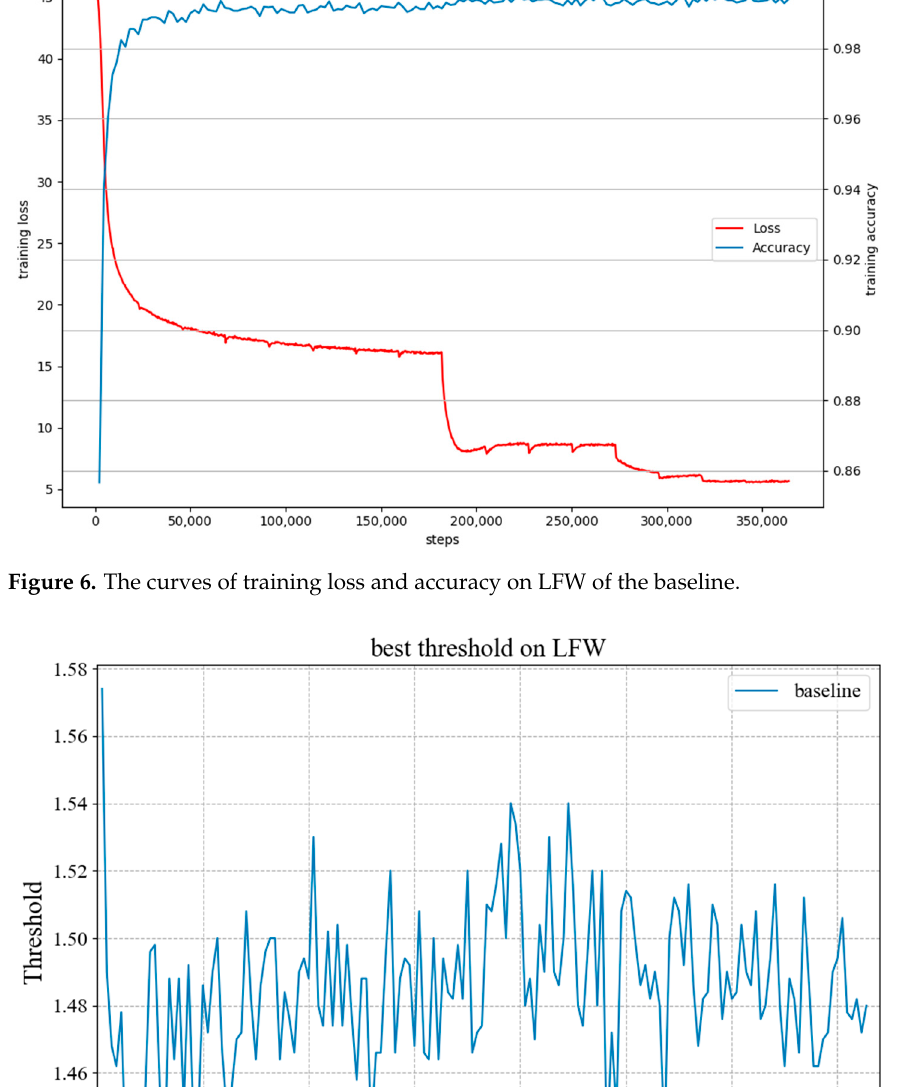
Figure 8. The ROC curves of the baseline on LFW, AgeDB-30, and CFP-FP. Combining the improved structures based on the channel attention mechanism pro- posed in Section 3.1, i.e., the depthwise SE (DSE) module, depthwise separable SE (DSSE)